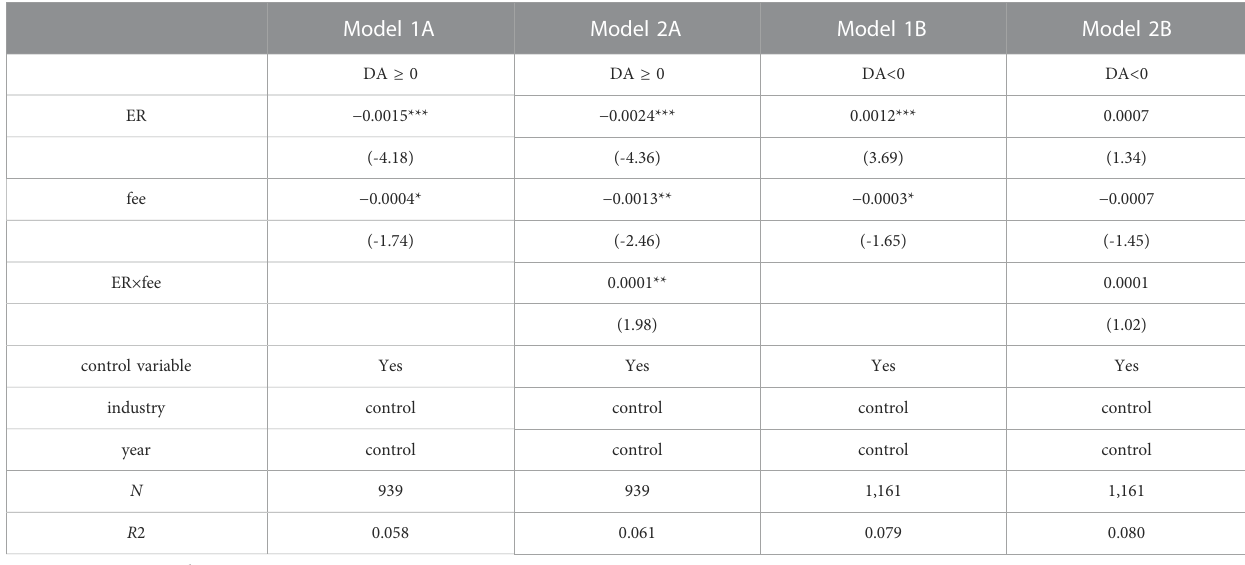
TABLE 6 Calculation results of accrual earnings management based on pro fi t